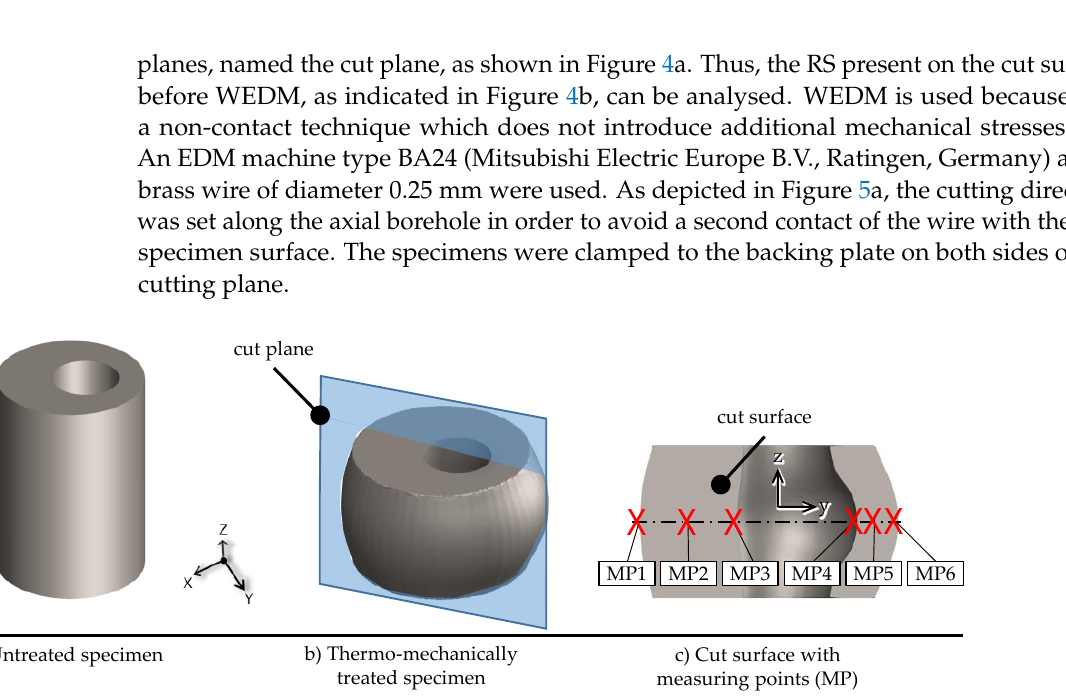
Figure 4. Illustration of the untreated ( a ) and the thermo-mechanically treated specimens ( b ), and the cut surface including measuring points MP1 to MP6 at the mid-height of the cut specimen ( c ).